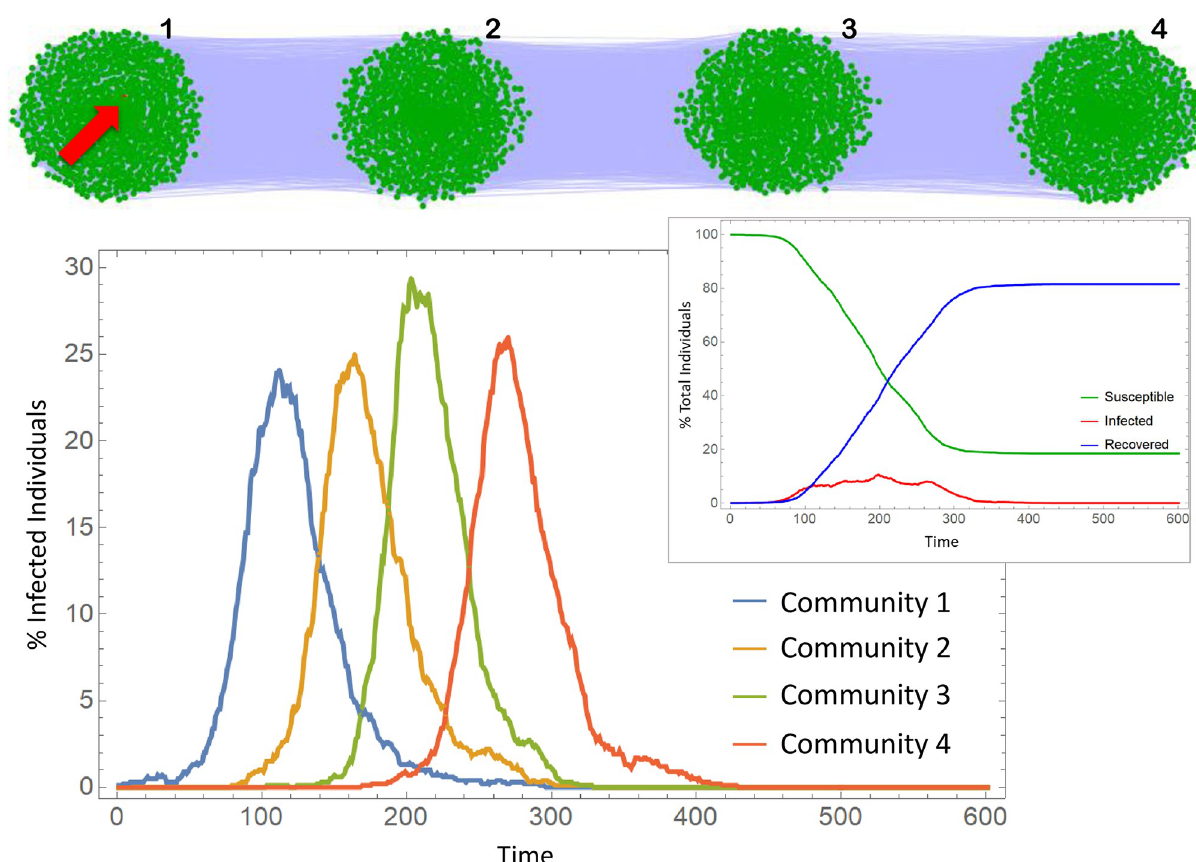
Fig 5. Contact network of four communities on a line and infection curves. Communities are Barabasi-Albert networks with 1000 nodes. We have kept the average degree constant and equal to 100 in all simulations. The infection starts with a single infected individual in the first community (red node indicated with the red arrow). The epidemic parameters are in S1